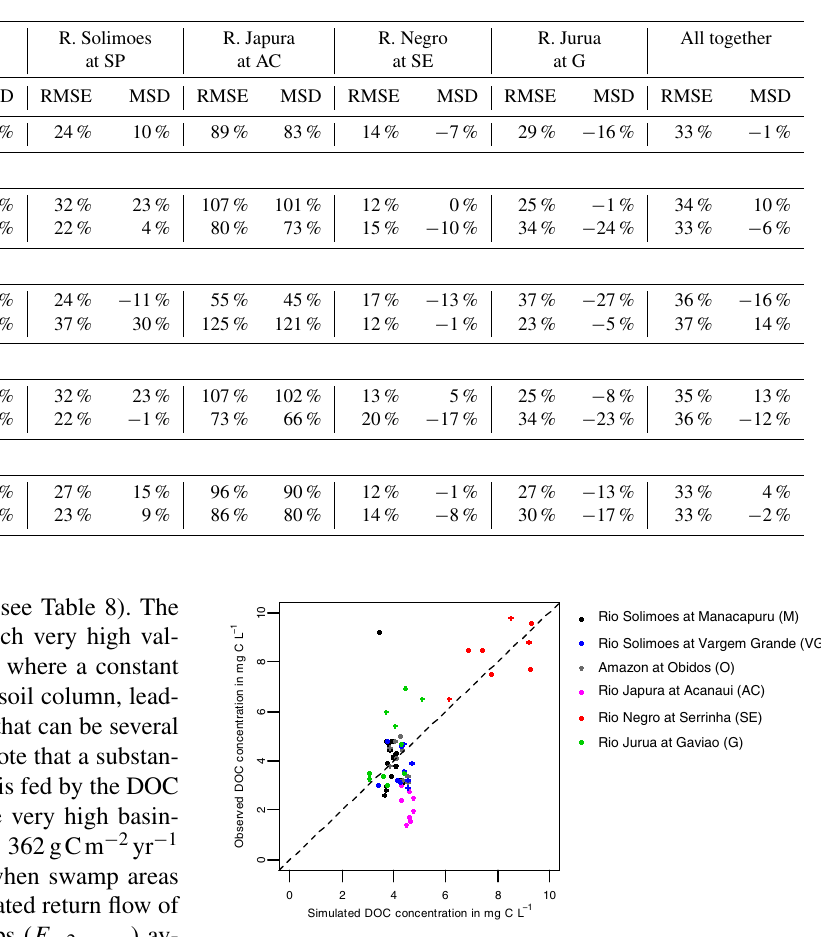
Table 9. Sensitivity analysis on the performance of simulating DOC concentrations. Performance measures, root mean squared errors (RM- SEs) and mean signed deviation (MSD), both relative to the mean observed concentration, are reported per sampling location, and for the whole set of observed DOC concentrations.